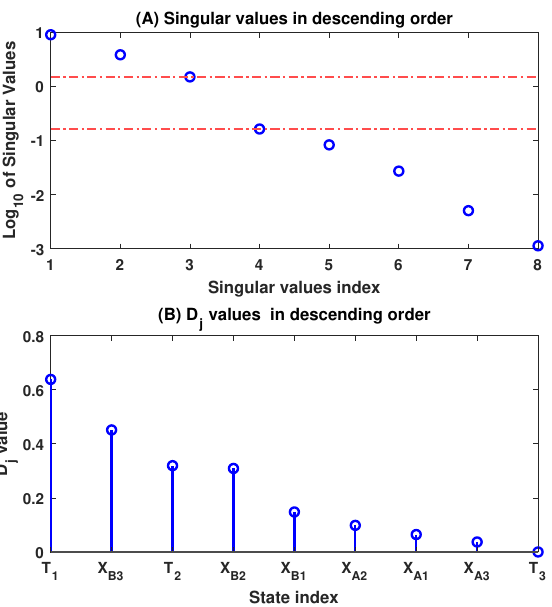
Figure 4. Singular values of S O and the D j values associated with the dominant singular